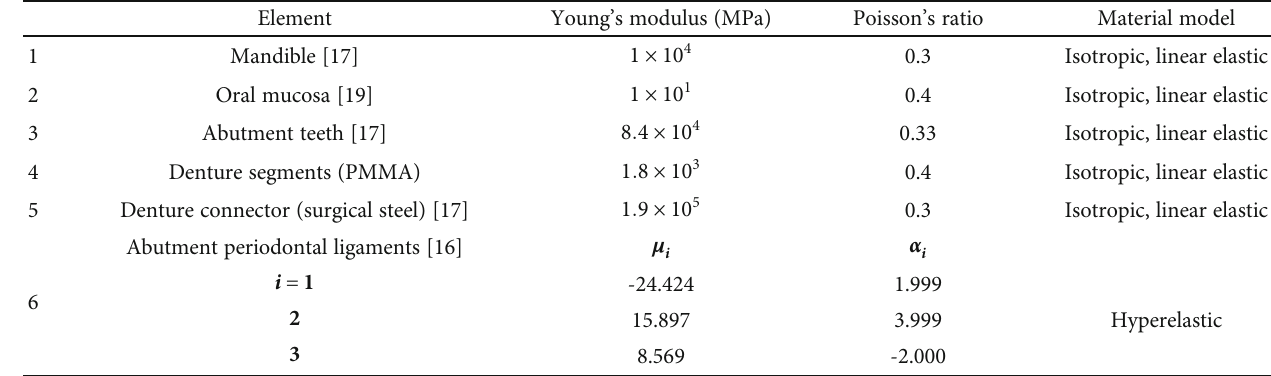
Table 1: Material parameters used for the components in the FE model.